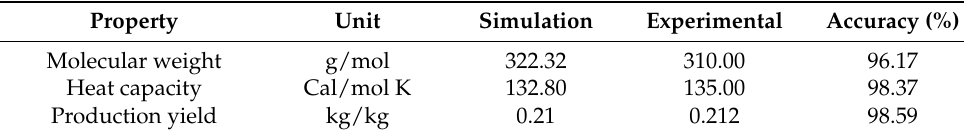
Table 2. Physical-chemical properties of chitosan provided by Aspen Plus ® modeling. Property